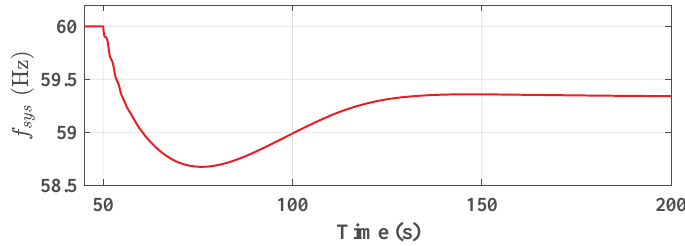
Figure 4. System frequency response to the G5 trip at t = 50 s (case study 1).